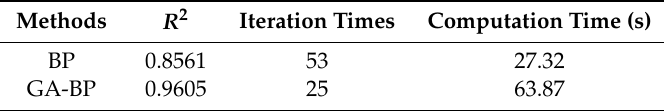
Figure 7. Comparison of the first roof weighting interval results: ( a ) the value of the first roof weighting interval predicted by the BP and GA-BP prediction models; ( b ) a comparison of the determination coe ffi cients predicted by the BP and GA-BP models. Table 6. Comparison of the BP and GA-BP